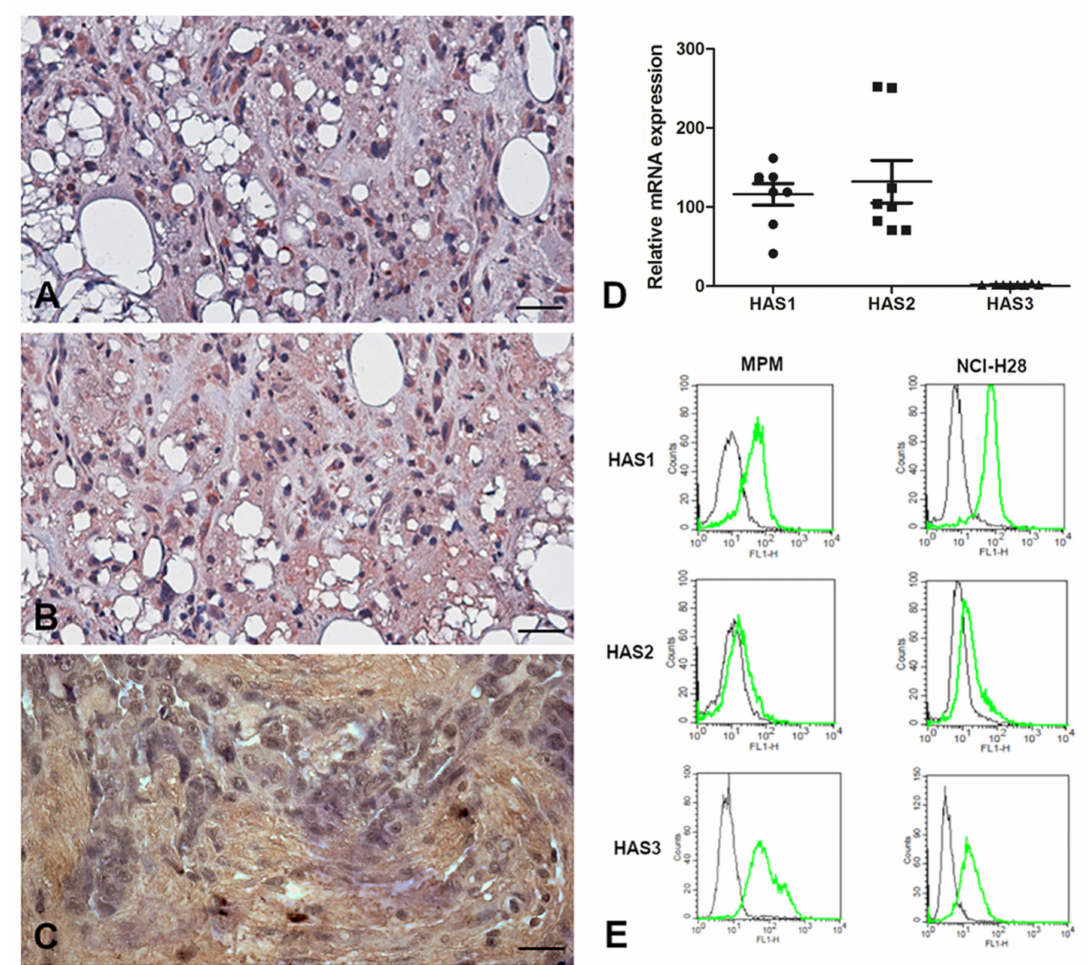
Figure 5. Characterization of HAS enzyme expression at the tissue level in MPM sections and in MPM cells. ( A – C ) Im- munohistochemical analysis of HAS enzymes in MPM tissues. MPM sections were probed for the detection of HAS1 ( A ), HAS2 ( B ) and HAS3 ( C ) expression at the tissue level, showing cytoplasmic and membrane presence of all the three HAS isoforms within the tumor region. Staining was revealed using a polymer detection kit (Novocastra, Leica Biosystems) and the AEC (3-amino-9-ethylcarbazole, Dako, Denmark) or DAB (3,3 (cid:48) -diaminobenzidine) substrate chromogen. Slides were counterstained with Harris Hematoxylin (Novocastra, Leica Biosystems). Magnification, 200 × , scale bar, 100 µ m. ( D ) Basal mRNA expression level of HAS enzymes in MPM primary cells using quantitative real-time PCR. Higher expression of HAS1 and HAS2 was highlighted. TATA box-binding protein ( TBP ) was used as a housekeeping gene to normalize gene expression results. Data were expressed as the means of experiments performed on eight different MPM populations in triplicates ± SEM. ( E ) Basal protein expression level of HAS enzymes in MPM cells using cytofluorimetric analysis. MPM cells were stained for HAS1, HAS2 and HAS3 and the fluorescence intensity of the cells incubated with primary antibodies (green line) was compared with unrelated staining (black line). All three enzymes were expressed by MPM primary cells. Basal protein expression level of HAS enzymes was also evaluated in NCI-H28, a human mesothelioma cell line. HAS enzyme expression in NCI-H28 cells appeared comparable to the one of MPM primary